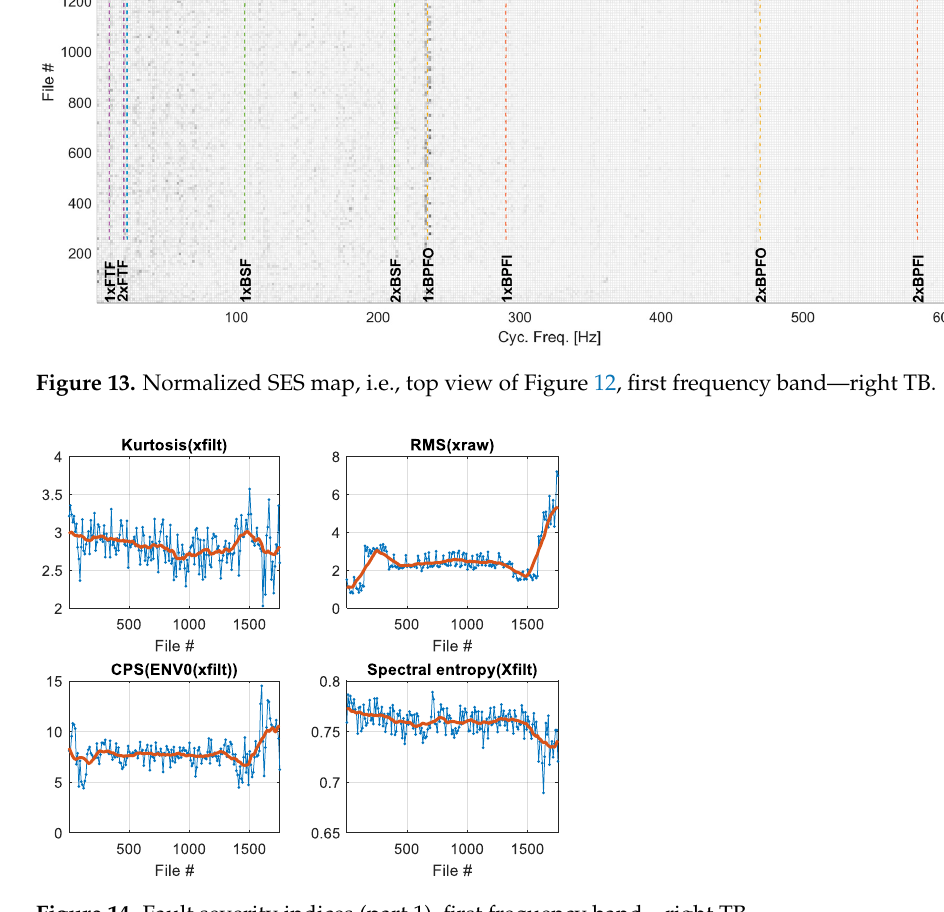
Figure 15. Fault severity indices (part 2), first frequency band—right TB.